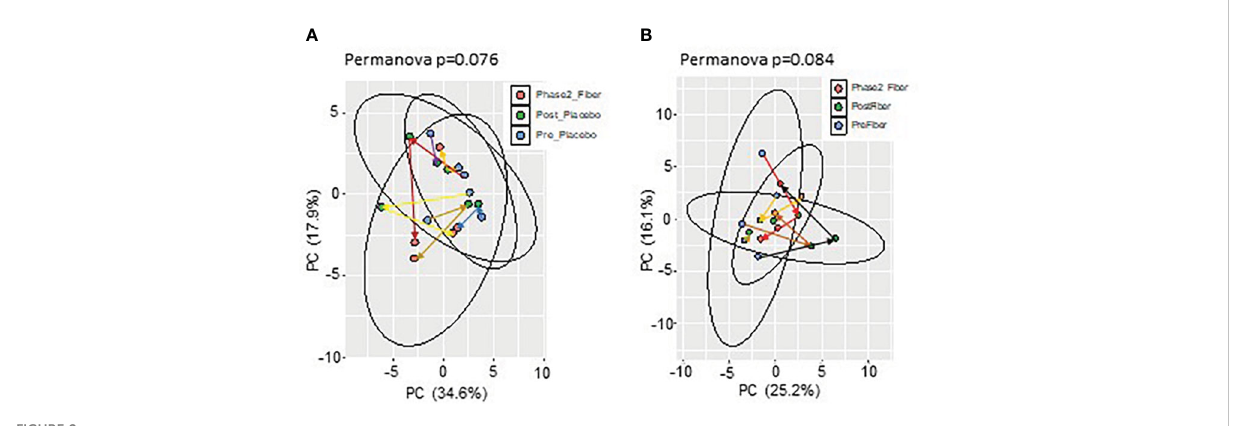
FIGURE 2 Principal component analysis of microbiome composition in Phase 1 and Phase 2. Trend for shifts in microbiome beta-diversity (A) between Pre_Placebo (pre metformin/placebo), Post_Placebo (post metformin/placebo) vs Phase2_Fiber (Phase 2 metformin/prebiotic) and (B)